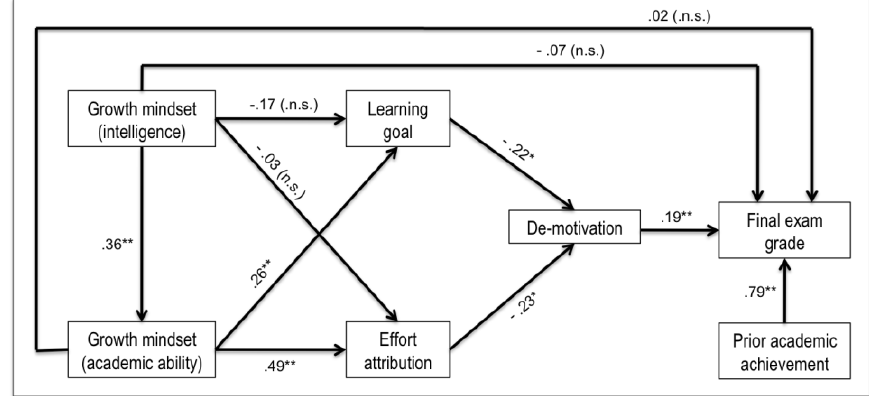
Figure 2. Path analysis results at the whole sample level. Figures show standardized